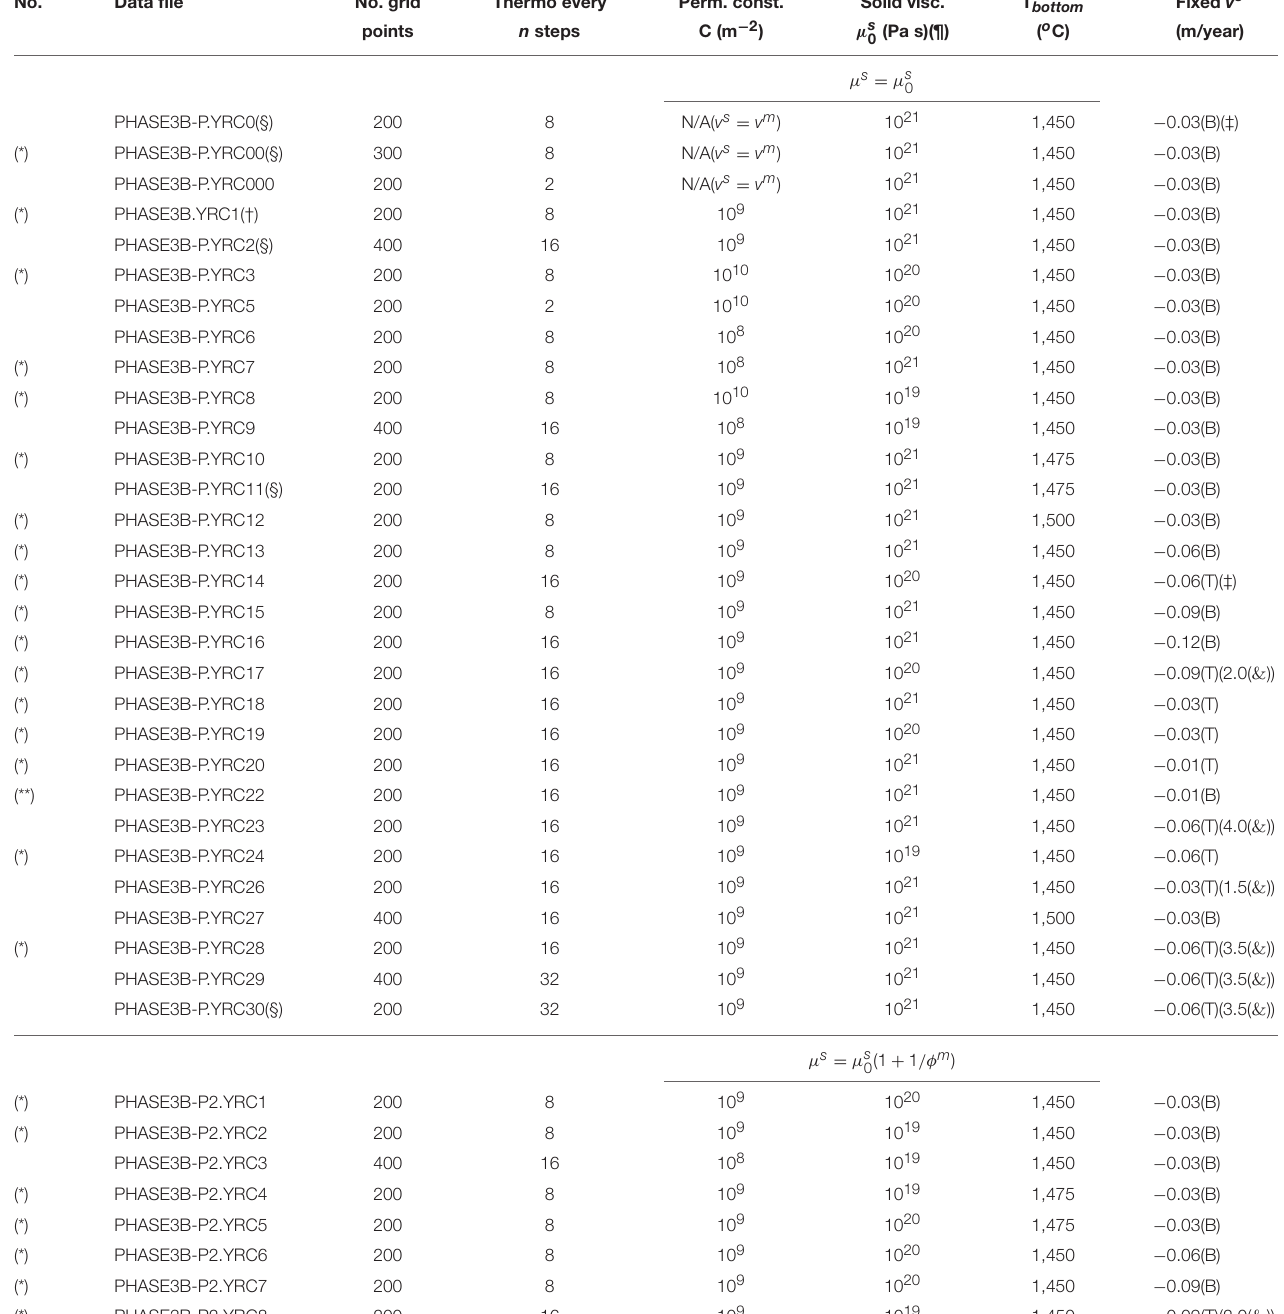
TABLE 1 | List of the dynamic fractional melting simulations (DFM).